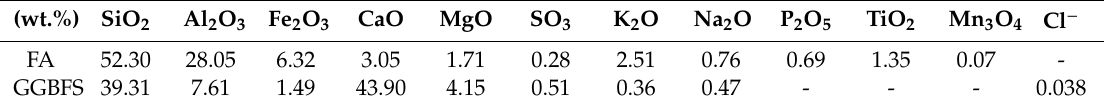
Table 1. Oxide composition of the fly ash (FA) and ground granulated blast-furnace slag (GGBFS) in wt.%, data supplied by the manufacturer. (wt.%) SiO